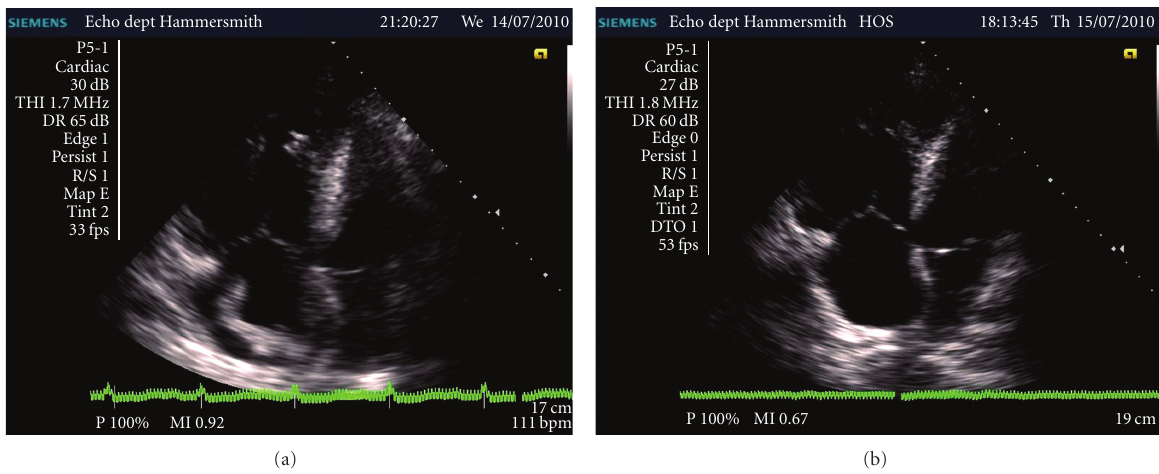
Figure 1: (a) shows “snake-like” thrombus within right atrium. (b) shows dissolution of thrombus post fibrinolytic agent.